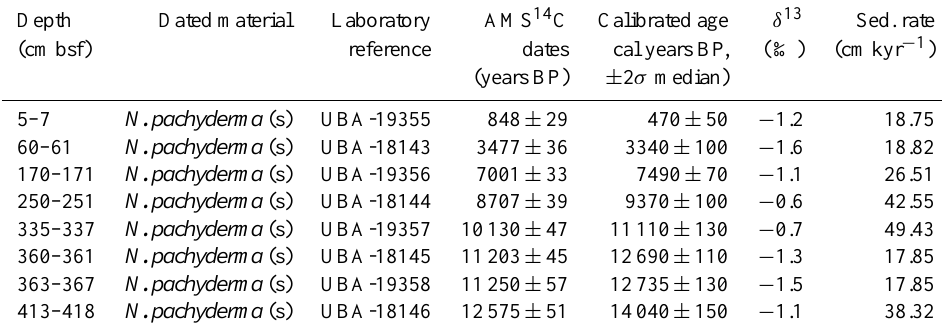
Table 1. Radiocarbon data and sedimentation rate a .